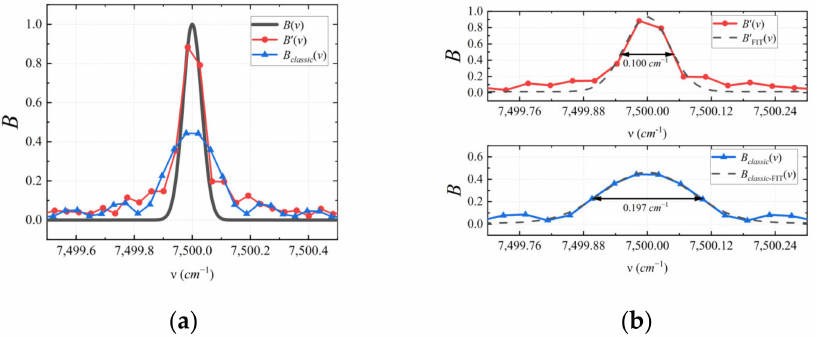
Figure 9. ( a ) The result of the super-resolution spectrum when the input spectrum is a Gaussian function; ( b ) FWHM of B (cid:48) ( ν ) and B classic ( ν ), where B (cid:48) FIT ( ν ) and B classic -FIT ( ν ) are the Gaussian-fitting functions of B (cid:48) ( ν ) and B classic ( ν ),